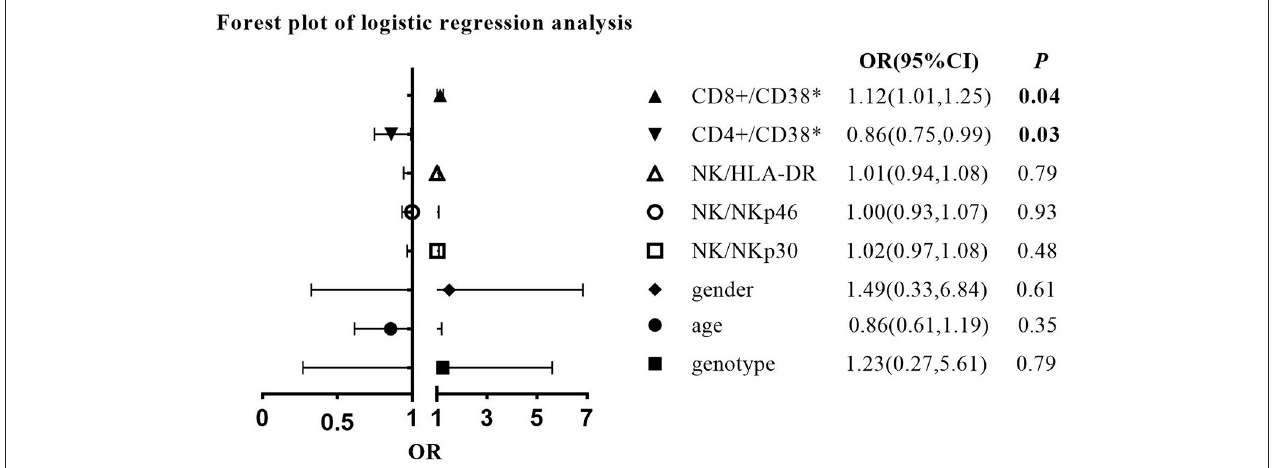
FIGURE 4 | Forest plot of multivariate logistic regression analysis comparing the immune-active (IA) phase with the immune-tolerant (IT) phase (IT phase is the reference group).